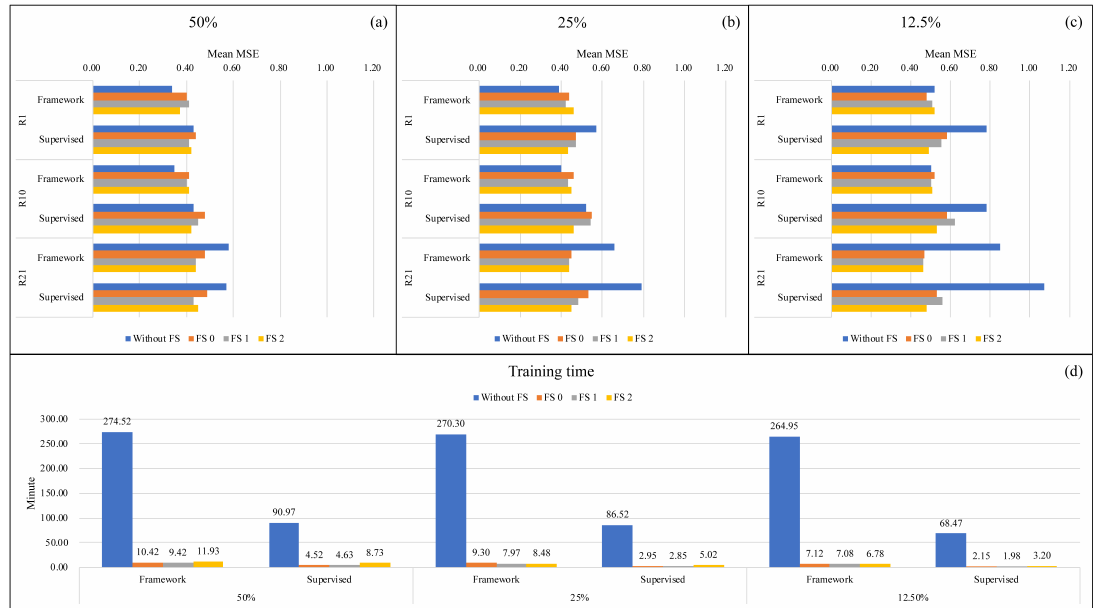
Figure 3. Conclusion of the performance analysis: ( a – c ) are the comparison of the mean MSE between different configurations of the networks trained on 50%, 25%, and 12.5% labeled data, respectively; ( d ) the comparison of the training time in minutes.